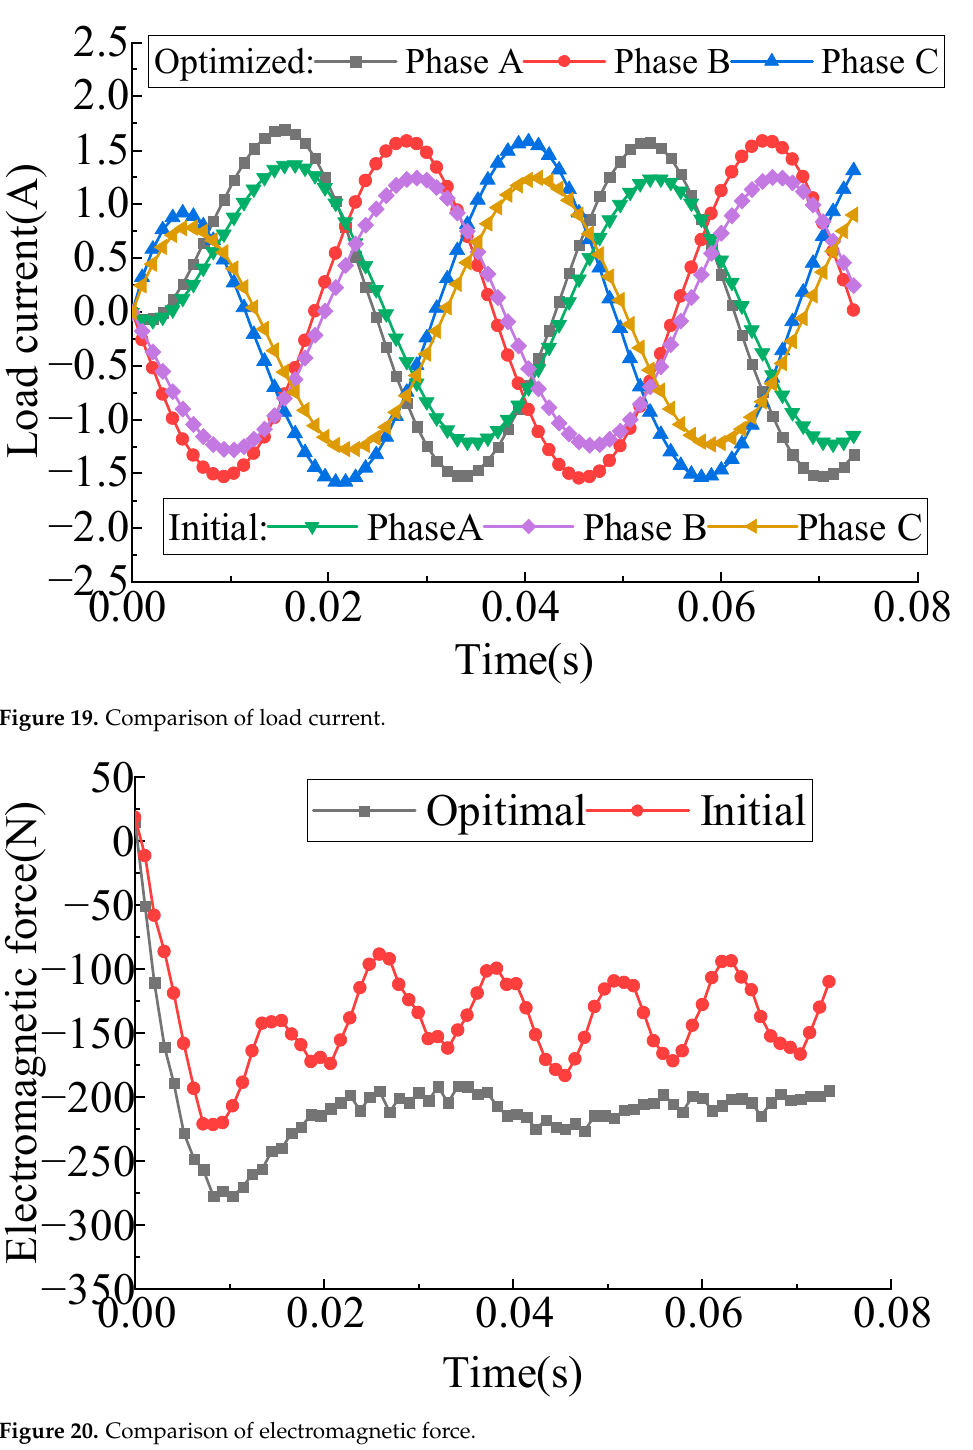
Figure 18. Comparison of load voltage.